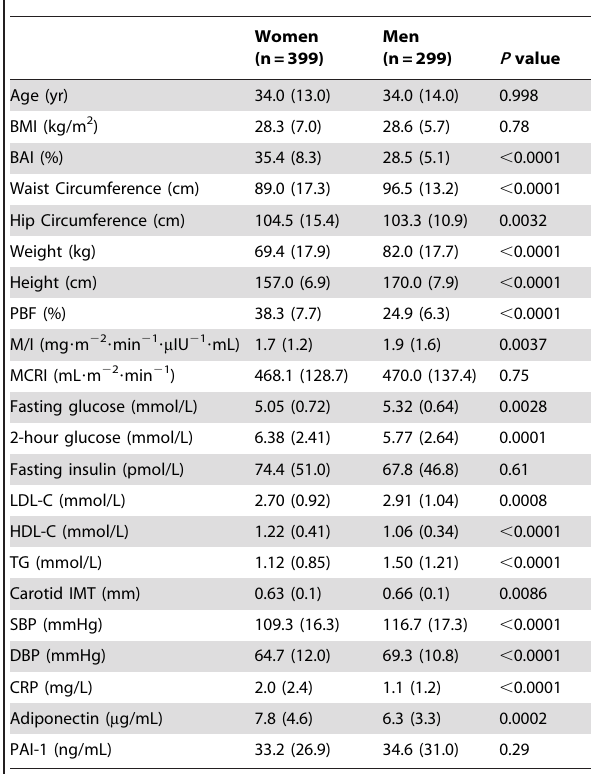
Table 1. Clinical characteristics of the study